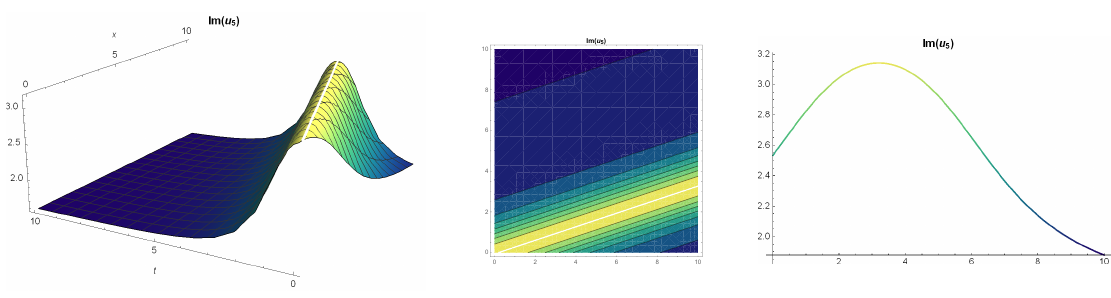
Figure 8. The imaginary part of 3D, contour and 2D graphs respectively for c 2 = 5, c 1 = − 1, q = − 1, p = − 0.5, w = 3 values of Equation (46).